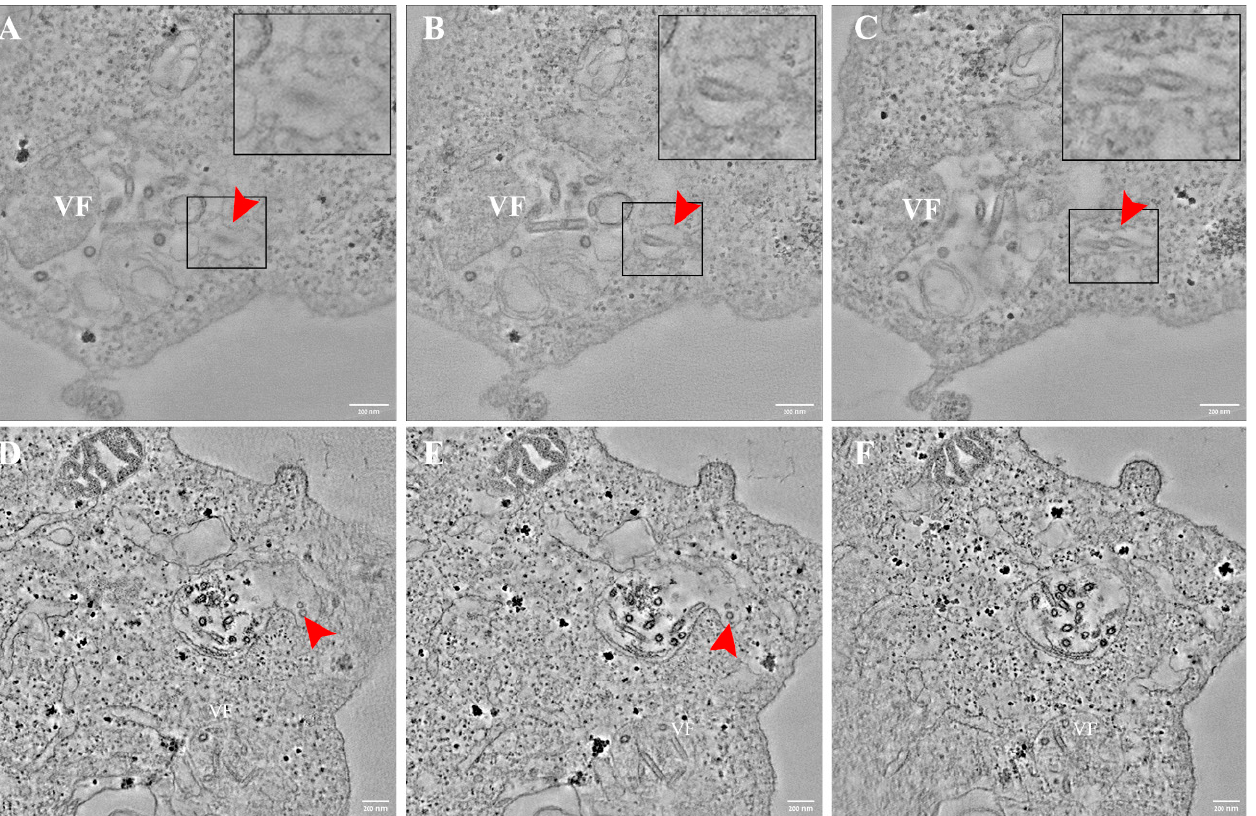
Figure 7. VSV-S particles are found in vacuoles after release from virus factories in multi lamellar bodies (MLB). ( A – F ) Sequential tomographic slices of VSV-S infected cells at 16 h ( A – C ) and 24 h post infection (PI) ( D – F ). Red arrows point toward several VSV-S particles inside a vacuole connected to MLB containing VF. Insets are high magnifications of delineated areas. Tomographic slices thicknesses are 13 nm ( A – C ) 4.3 nm ( D – F ). Scale bars are 200 nm.